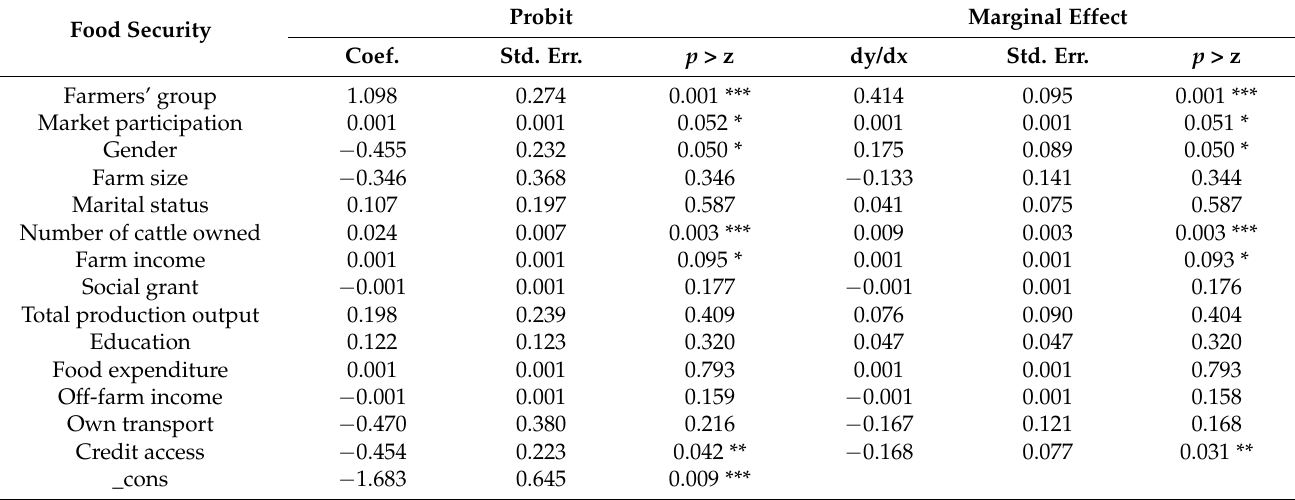
Table 6. Determinants of the household food-security status of